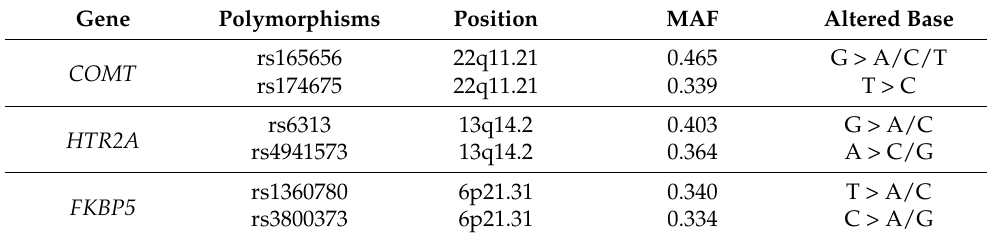
Table 1. Polymorphisms studied and respective characteristics in general population.